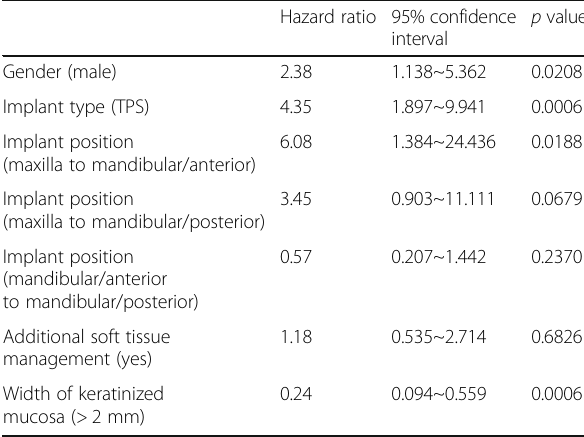
Table 6 Cox regression analyses for cumulative incidence of